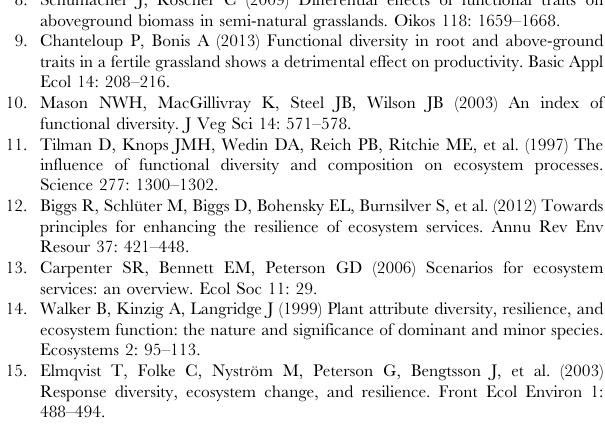
Table S1 Productivity correlations with non-leaf traits. Model parameters, parameter probabilities and model fits for alternative models linking traits to production. Table S2 Stages in productivity model simplification. Random and fixed model parameters in the stages of model simplification [28]. Table S3 Models combining productivity and functional diversity. Tests of adding functional diversity parameters to the trait and climate model using maximum likelihood and a likelihood ratio statistic to assess their additional explanatory power.